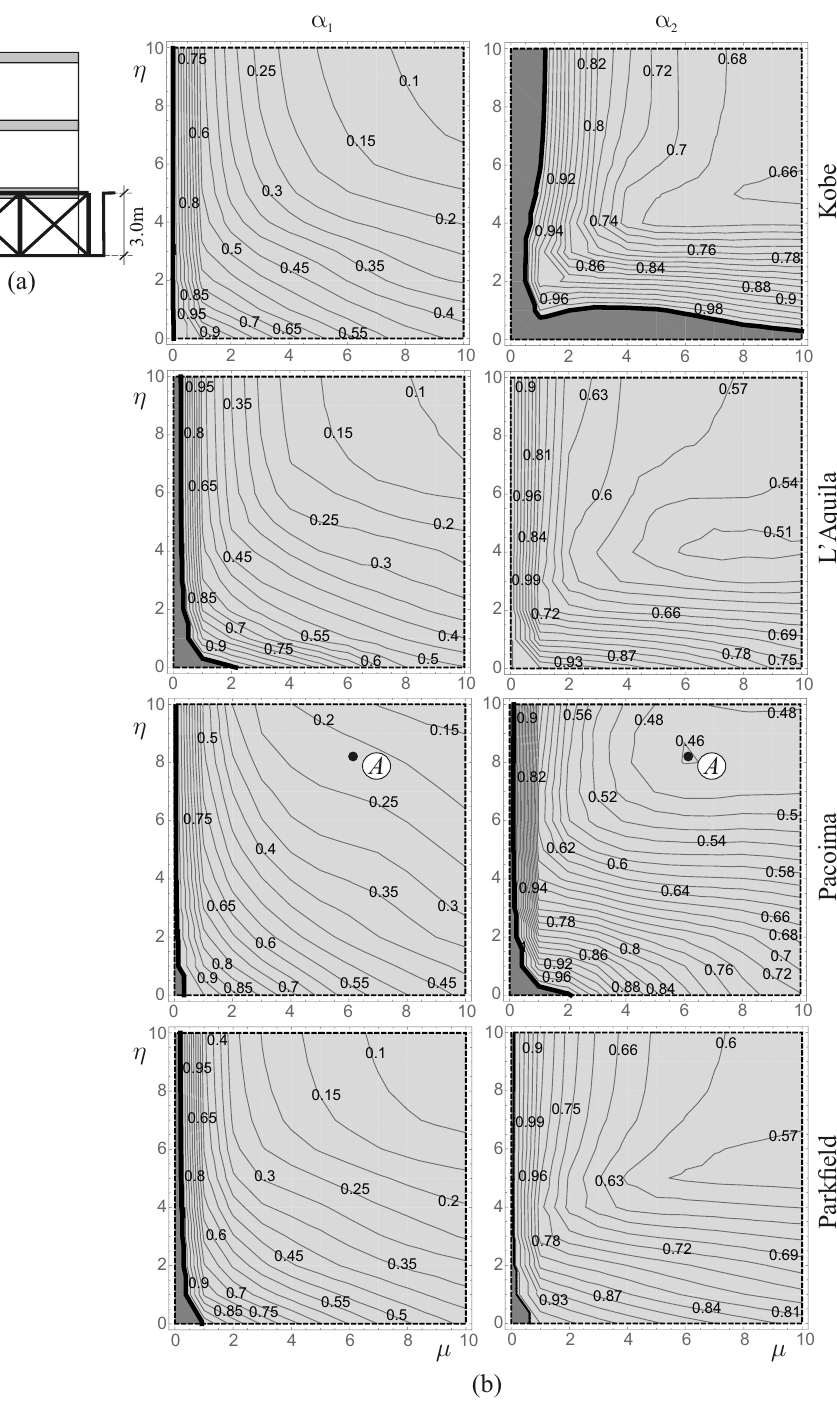
Figure 10. Gain maps: ( a ) Geometrical coupling scheme; ( b ) Gain maps α 1 and α 2 for different earthquakes ( ψ = 0.1, γ = 0.1). Point A denotes a reference case examined in the analyses. Figure 11 shows the time-histories of u 1 ( t ) and ∆ u ( t ) together with the hysteretic cycle. Such curves refer to the point labelled with A in the Pacoima maps of Figure 10. The comparison between the time-histories of the coupled system (thick line) and those of the stand-alone structure (thin line) shows a notable reduction in both the displacement of the sub-structure and the drift of the super-structure due to the coupling. Moreover, the hysteretic cycle in Figure 11 clearly shows the yielding of the system and the consequent energy